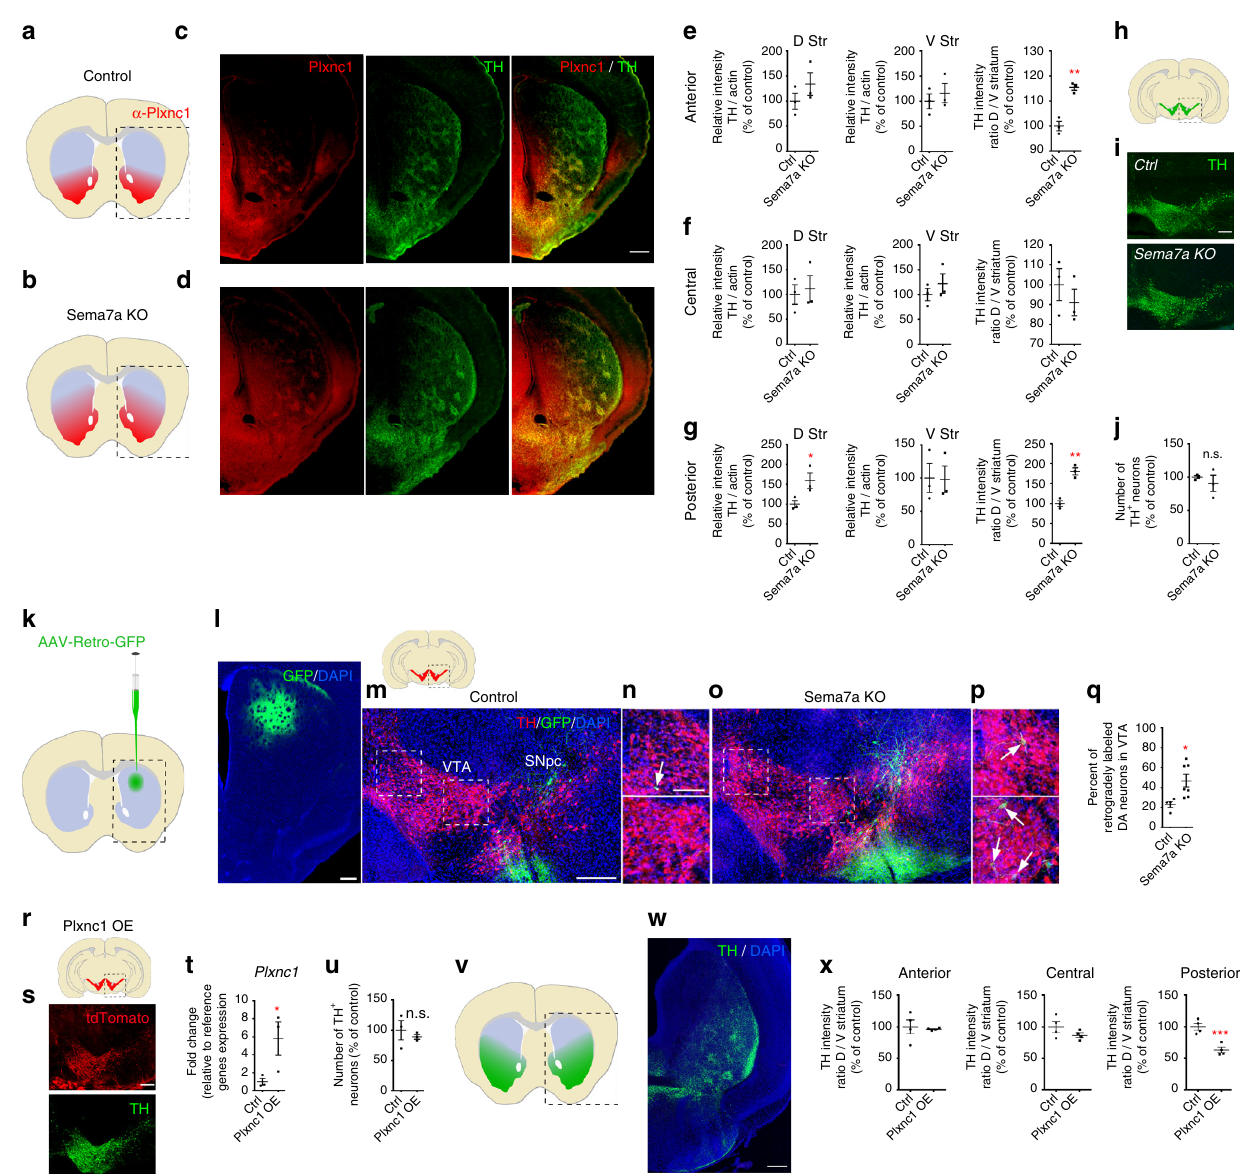
Fig. 7 Sema7a/Plxnc1 interaction regulates mDA axon guidance. a , b Schematic representations of coronal views of the axonal projections in the striatum showing that Plxnc1 mDA axons (in red) are more numerous in the dorso-posterior striatal region of Sema7a KO mice ( b ) compared to control animals ( a ). c , d Confocal images of TH and Plxnc1 immunostained striatal sections from control and Sema7a KO mice. e – g Quanti fi cation of TH relative optical density at different striatum levels ( n = 3, two-tailed unpaired t test, p (Ant D) = 0.2855, p (Ant V) = 0.5355, p (Cent D) = 0.7461, p (Cent V) = 0.3933, p (Post D) = 0.0491, p (Post V) = 0.9514, p (Ant D/V) = 0.0023, p (Cent D/V) = 0.4418, p (Post D/V) = 0.0023). h Schematic representation of coronal section of mouse brain at the midbrain level. Dashed line indicates the boundaries of the pictures shown in i . i Representative confocal images of the VTA and SNpc for Control and Sema7a KO mice. j Stereological counts of mDA neurons in control and Sema7a KO mice at P1 ( n = 3, two-tailed unpaired t test, p = 0.4843). k Schematic representation of the injection site of the AAV-retro-GFP in the dorsal striatum. l Representative confocal images of the injection site in the dorsal striatum. m – p Representative confocal images of the retrogradely labeled cells in control ( m , n ) and in Sema7a KO mice ( o , p ) 17 days after injection in the dorsal striatum at P30 (TH in red, AAV-Retro-GFP in green and DAPI in blue). n , p Higher magni fi cations in the VTA as indicated by the dashed boxes in m , o . q Quanti fi cation of the percentage of retrogradely labeled neurons in VTA (GFP + TH + in VTA on total GFP + TH + ; n = 4 for controls and n = 7 for Sema7a KO mice; two-tailed unpaired t test, p = 0.0245). r , s Schematic and confocal images of TH labeling in Plxnc1 overexpression mice showing a loss of DA innervation in dorso-posterior striatum. t RT-qPCR quanti fi cation of Plxnc1 from the ventral midbrain section of control and Plxnc1 overexpression mice at P1 ( n = 3, one-tailed unpaired t test, p = 0.0322). u Stereological counts of mDA neurons in control and Plxnc1 overexpression mice at P1 ( n = 3, two-tailed unpaired t test, p = 0.5431). v , w Schematic and confocal images of TH and td-Tomato in the VTA and SNpc for one hemisphere. The reporter tdTomato indicates that all mDA neurons express the transgene (Plxnc1-ires-tdTomato). x Optical density measurements of TH-positive axons in the striatum at three antero – posterior levels ( n = 4, two-tailed unpaired t test, n = 4, Mann – Whitney U , p (AntD/V) = 0.6857, two-tailed unpaired t test, p (CentD/V) = 0.1945, p (Post D/V) = 0.0019). Scale bars: 200 µ m except n , p , 100 µ